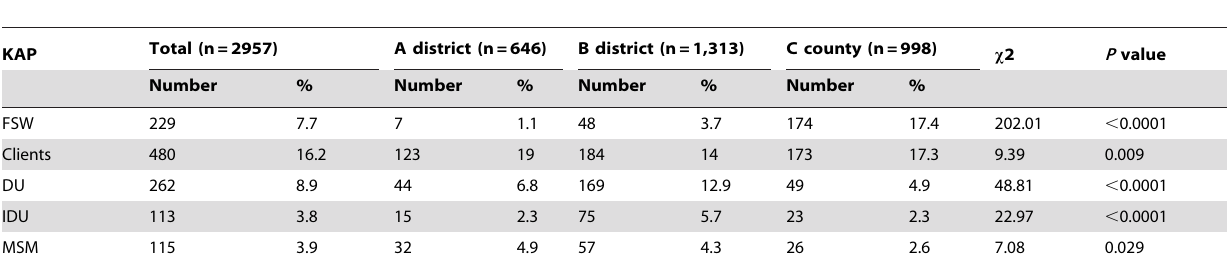
Table 3. The number of respondents who knew KAP, by district/county, Chongqing, China (2011).